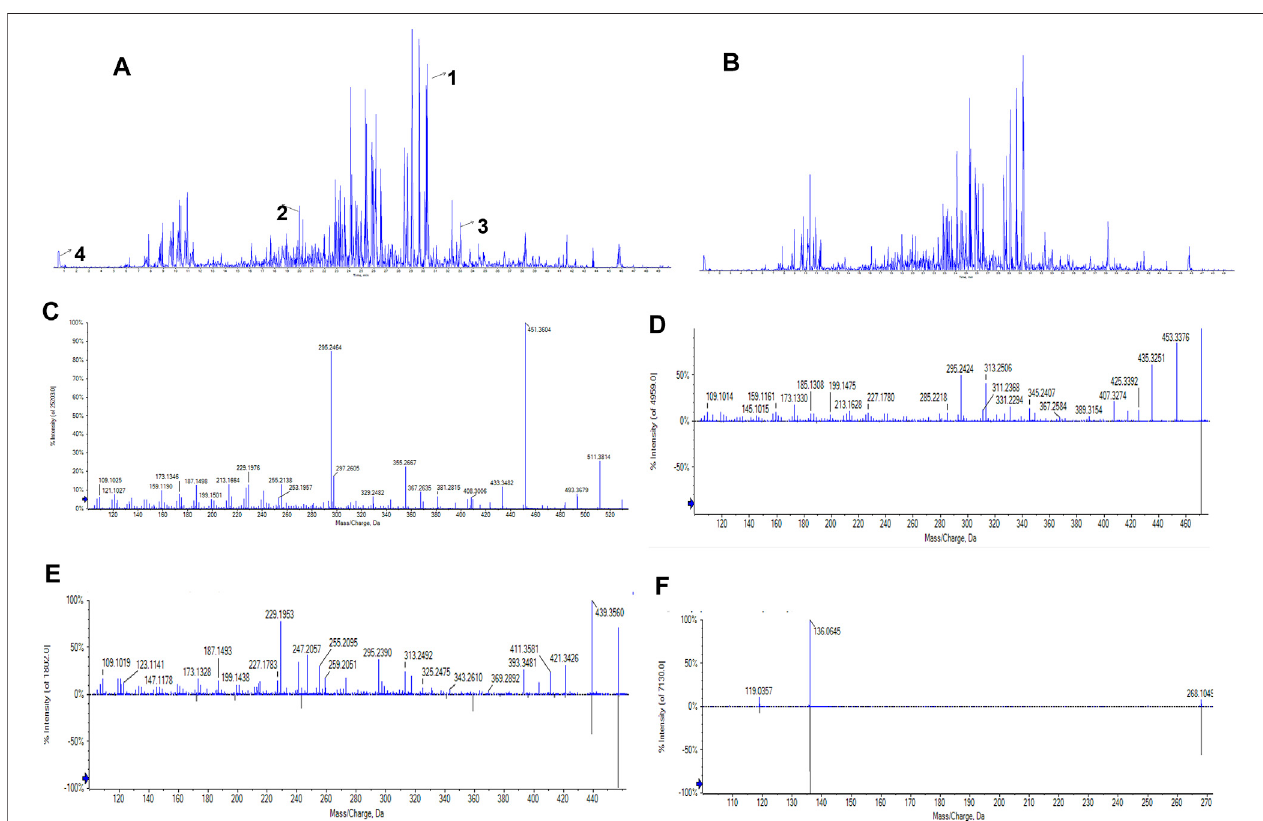
FIGURE 1 | UPLC/Q-TOF-MS total ion current chromatogram of the PRP alcohol extract. (A) Total ion current chromatogram in positive ion mode. Numbers represent the following compounds:1. Pachymic acid, 2. Glycyrrhetinic acid, 3. Oleanolic acid, 4. Adenosine. (B) Total ion current chromatogram in negative mode. The retention times of the four compounds were 30.317, 19.867, 33.012, and 0.55 min, respectively. (C) MS/MS spectrum of pachymic acid; (D) MS/MS spectrum of glycyrrhetinic acid; (E) MS/MS spectrum of oleanolic acid; (F) MS/MS spectrum of adenosine.